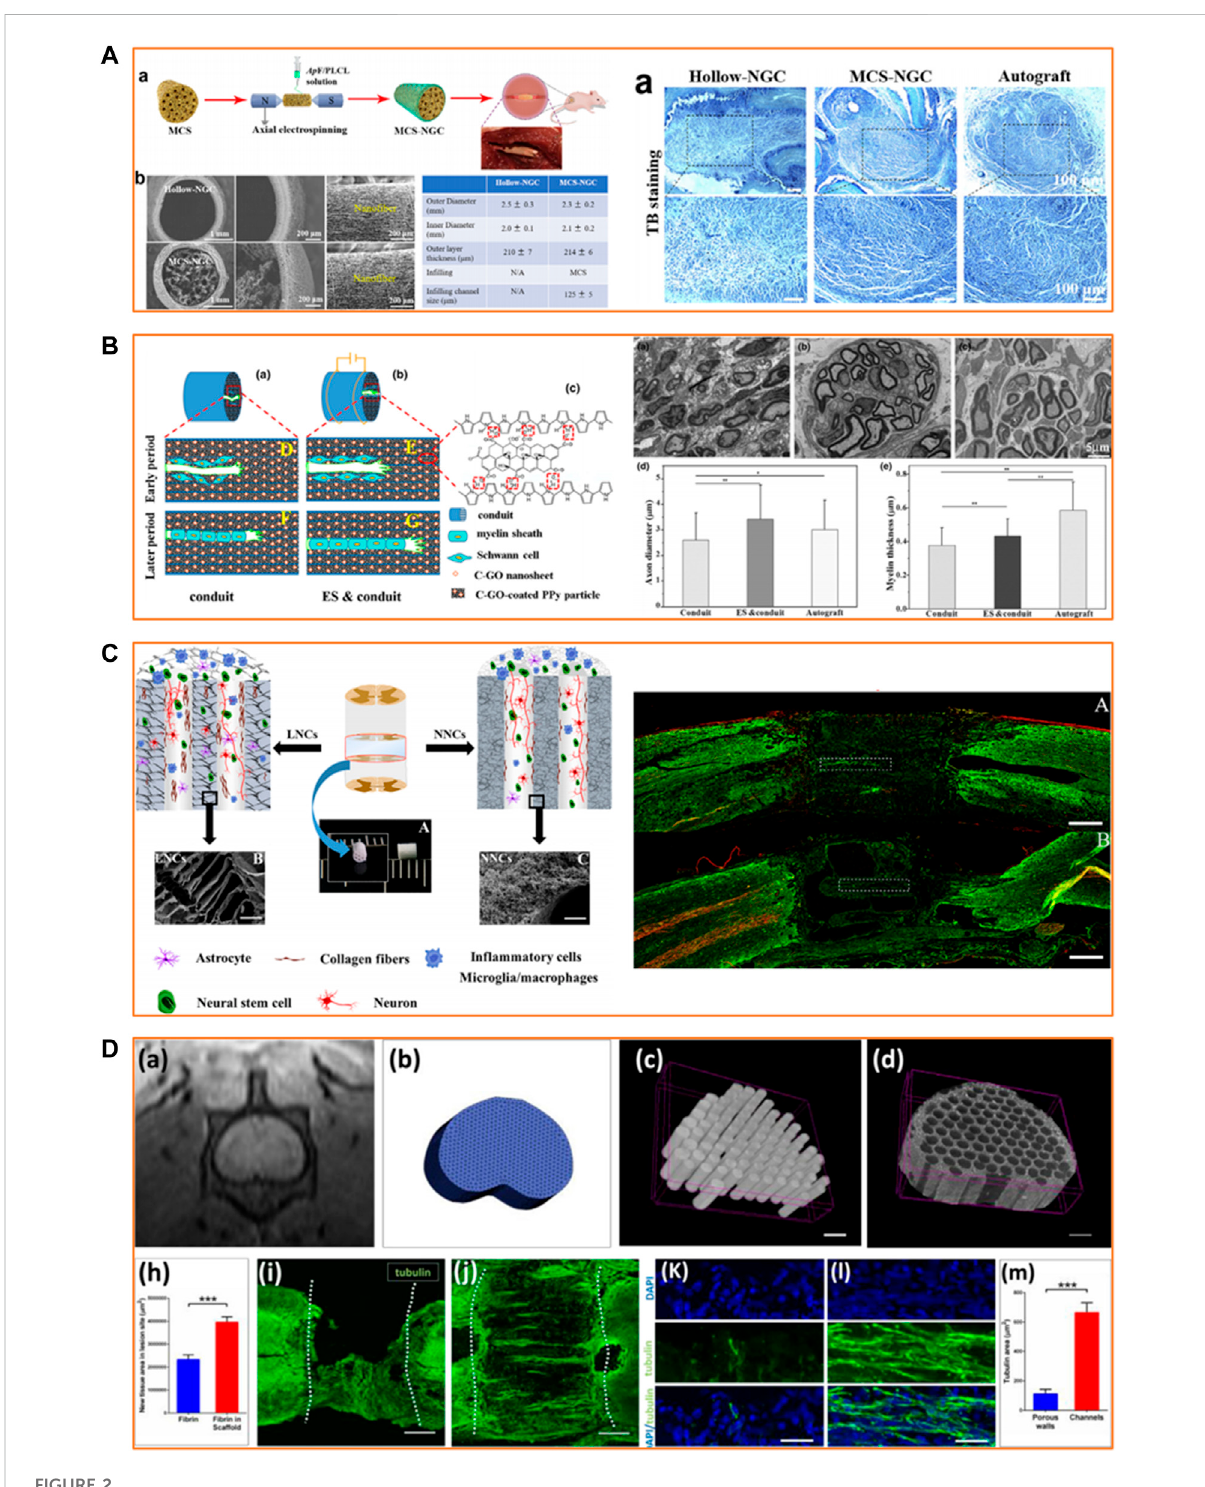
FIGURE 2 Applications of PLLA-based scaffolds in peripheral nerve and spinal cord regeneration. (A) Effective guiding support provided by biomimetic PLLA-based scaffolds for peripheral nerve regeneration. Reproduced with permission from Ref. (Wang et al., 2020). Copyright 2020, Elsevier. (B) Satisfying neurite growth induced by CGO/Ppy/PLLA scaffold under electrical stimulation for peripheral nerve regeneration. Reproduced with permission from Ref. (Chen X. et al., 2019). Copyright 2019, John Wiley and Sons. (C) Recruitment of endogenous stem cells by PLLA-based multi-channel scaffolds for spinal cord regeneration. Reproduced with permission from Ref. (Sun et al., 2019b). Copyright 2018, Elsevier. (D) Facilitation of axonal growth by a combination of PLLA-based scaffolds and stem cell therapy for spinal cord regeneration. Reproduced with permission from Ref. (Kaplan et al., 2020). Copyright 2020,